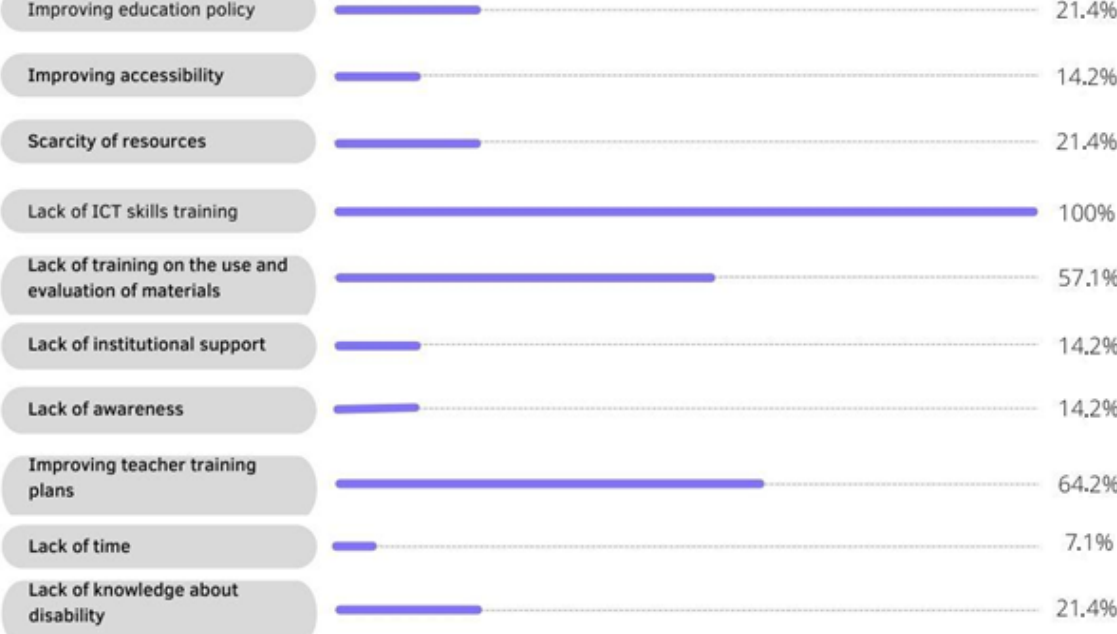
Figure 5. Keyword co-occurrence map.